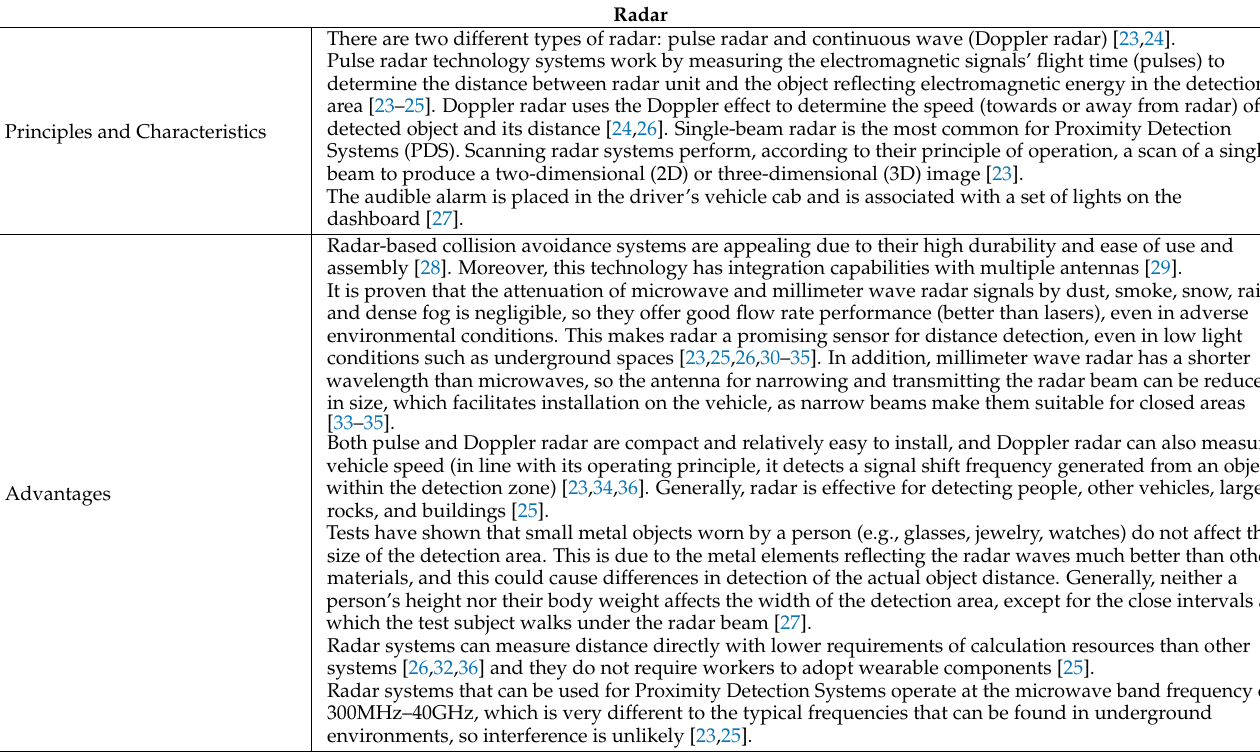
Table 5. Results of review of the